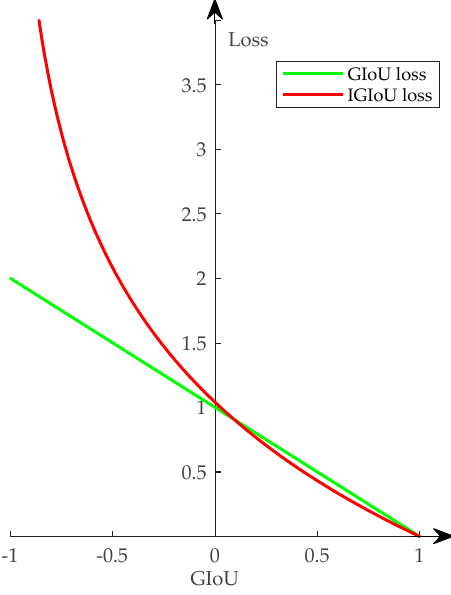
Figure 3. Illustration of GIoU and IGIoU